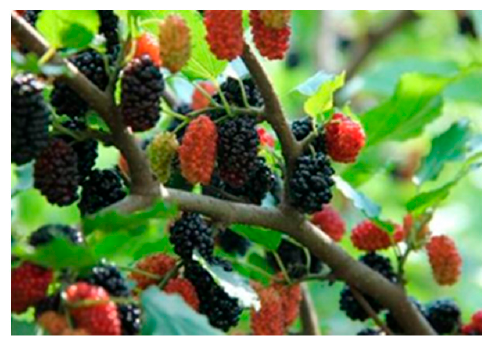
Figure 6. Jujube ( Ziziphus jujuba Mill.).